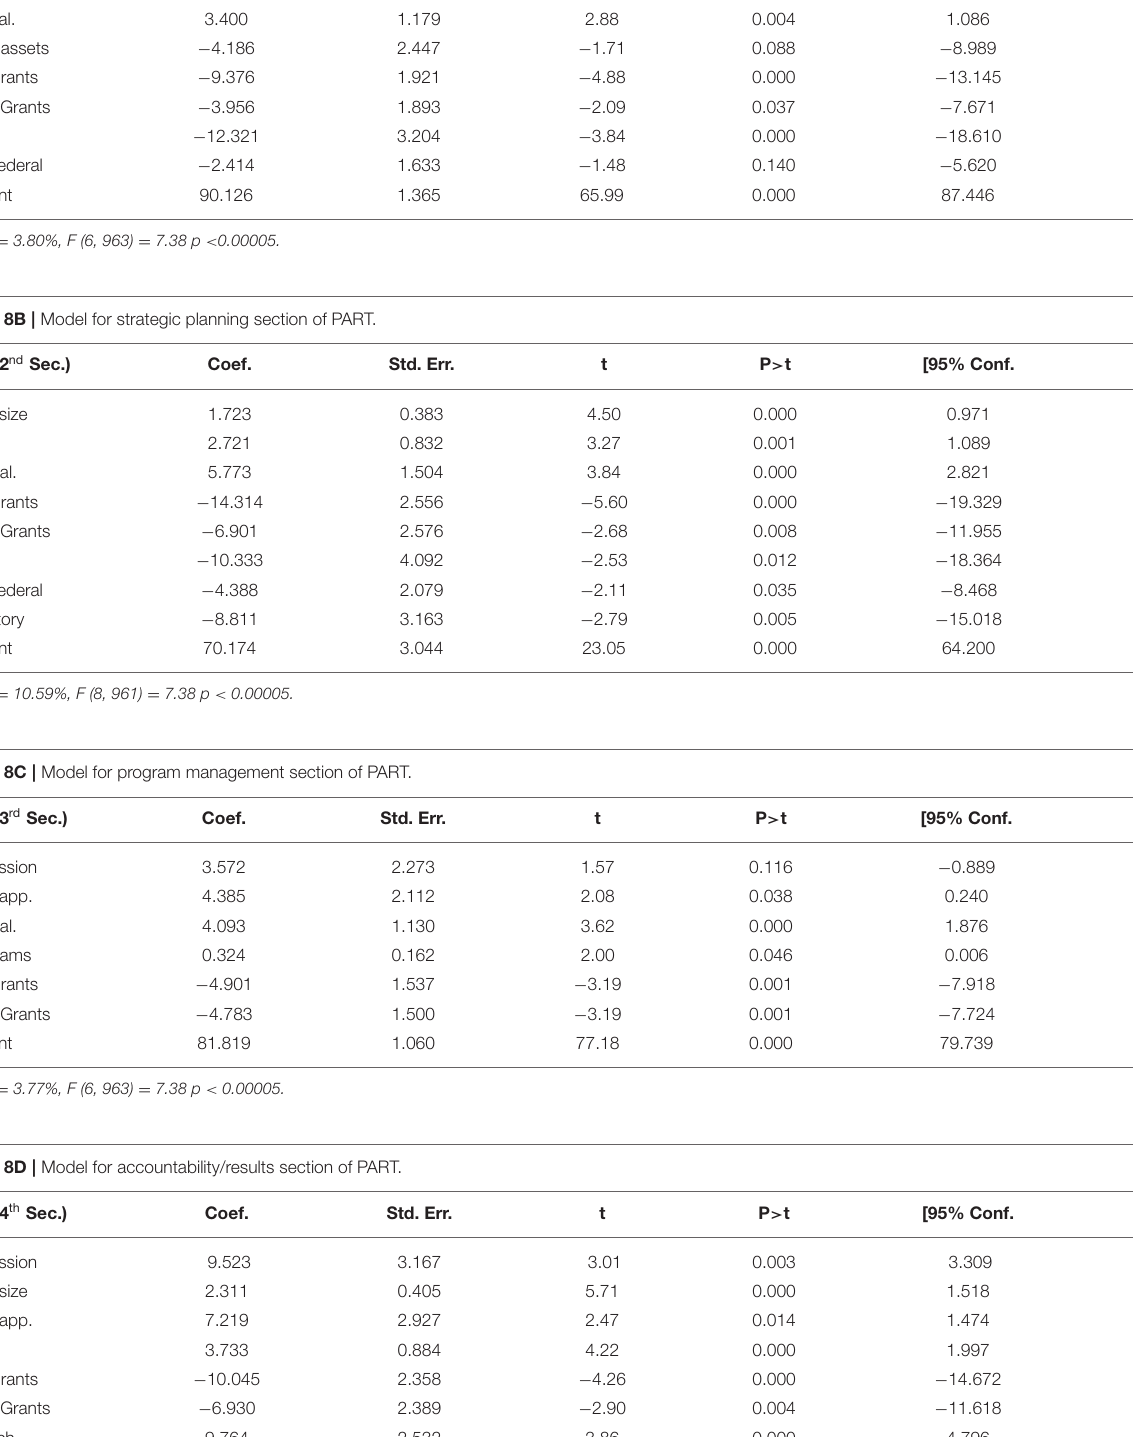
TABLE 8A | Model for purpose and design section of PART. PART (1 st Sec.) Coef. Std. Err. t P > t [95% Conf.